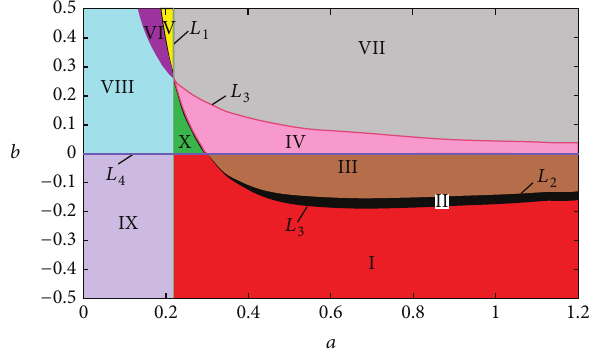
Figure 4: The stable domain on the parameter plane (𝑎, 𝑏) with 𝑐 = = 0.8 , 𝑘 = 0.5 0.08 , and 𝑘 1 2